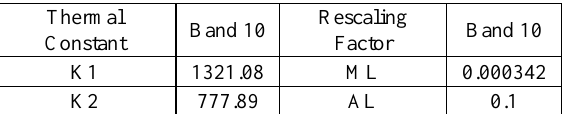
Table 3. Rescaling Factor and Thermal Constant values